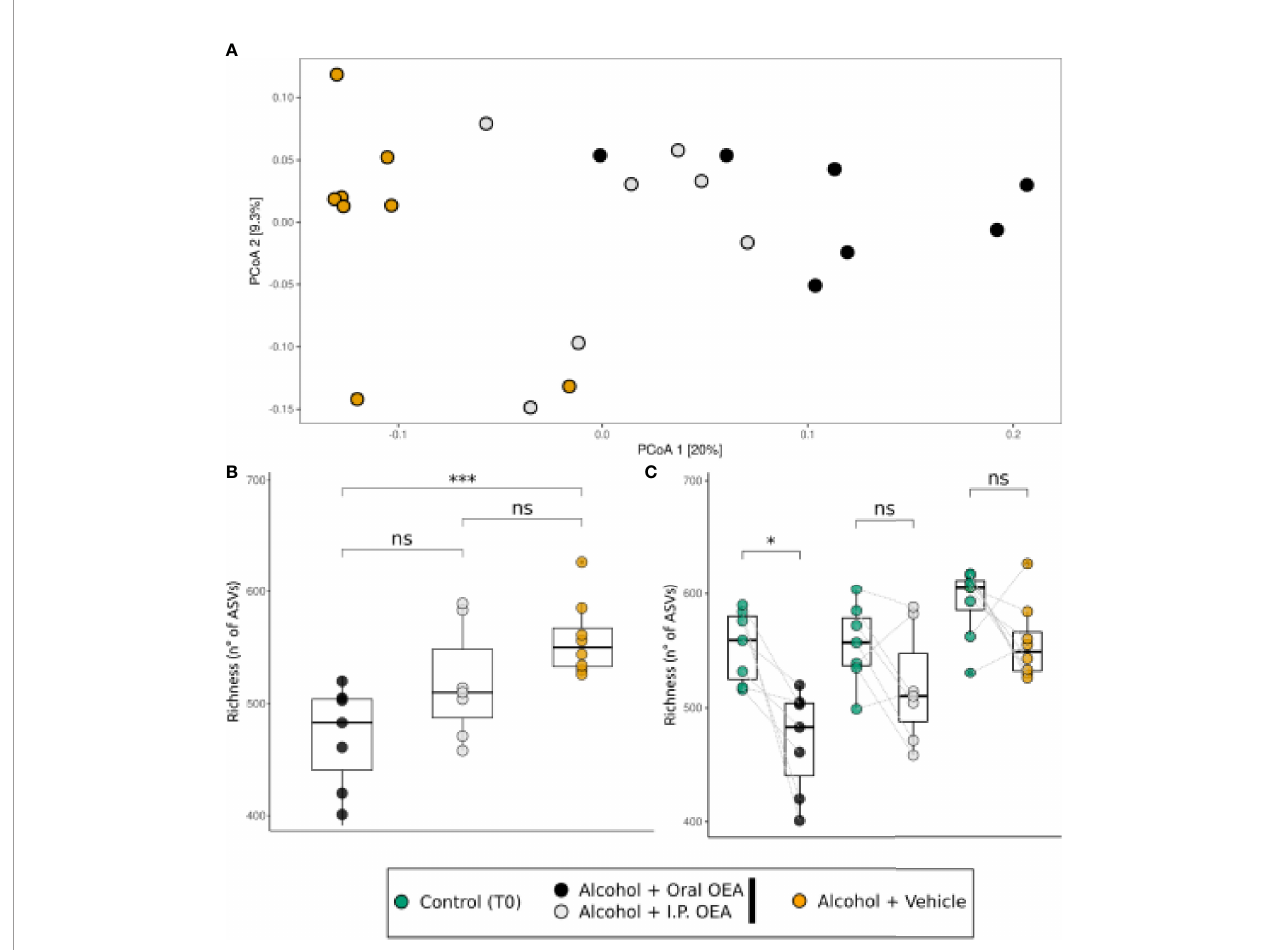
FIGURE 6 | Bacterial community response to different routes of administration of OEA in alcohol-intoxicated rats. (A) b -Diversity analysis with PCoA ordination among the oral and i.p. OEA administration route, in comparison with the non-OEA-receiving rats. Ordination was constructed using the Bray – Curtis distance measure. (B) Richness (number of different ASVs) in the three sample groups. (C) Richness (number of different ASVs) in the three sample groups, in comparison with their respective T0 samples. Differences between groups were tested by Wilcoxon rank-sum test [paired test in panel (C) ] and the resulting p -value was reported as notation on the plot (ns, p -value > 0.05; * p -value < 0.05; *** p -value < 0.001). Dotted lines connect the data from the same animal at the two time points for each treatment. T0 group, n = 22; alcohol + vehicle group, n = 8; alcohol + oral OEA group, n = 7; alcohol + i.p. OEA group, n =